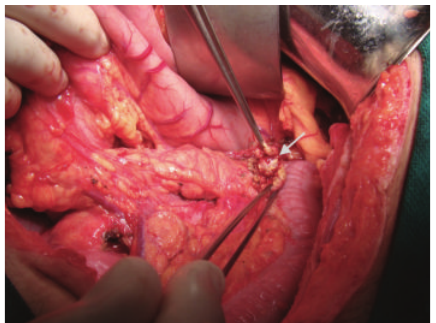
Figure 4: A nodular lesion in the body of the pancreas. Figure 5: A nodular lesion in the tail of the pancreas.